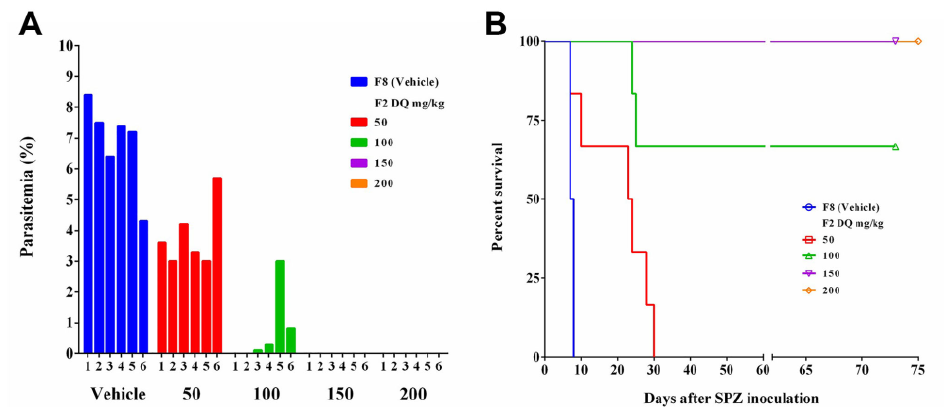
Figure 5. In vivo efficacy validation of effective dose of DQ in SRFD. SRFD (F2) with different doses of DQ were placed one month before P. berghei 868 SPZ inoculation. ( A ) Parasitemia was detected by examining blood smears from mice 6 days after the SPZ inoculation. ( B ) Percent survival rates of animals 75 days after the SPZ inoculation.